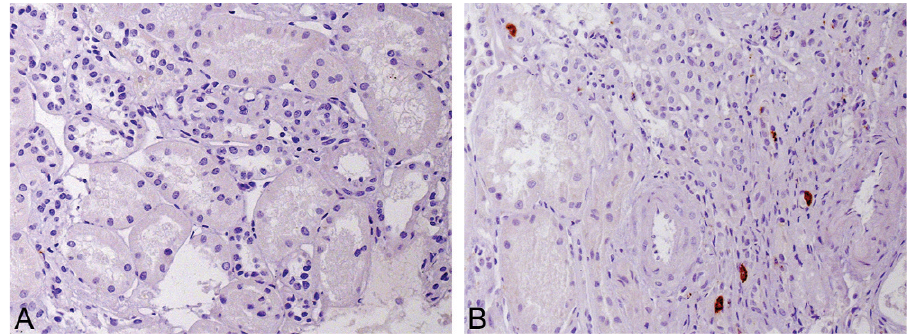
Figure 1 - Renal macrophage infiltration. (A) The absence of macrophages in a preserved area of the cortex, and (B) macrophages within areas of interstitial fibrosis (A and B: objective 40x).